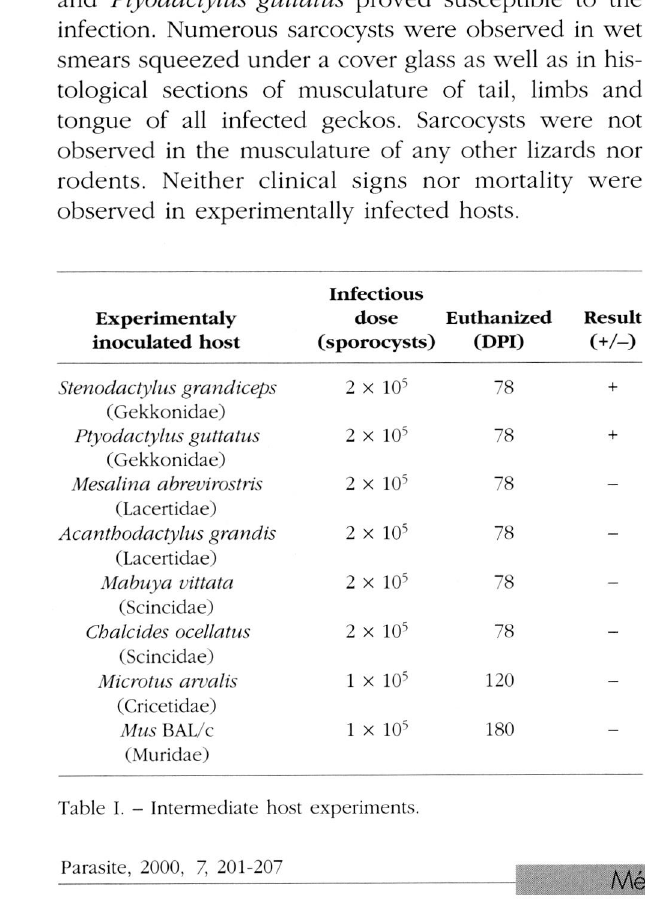
Table I. - Intermediate host